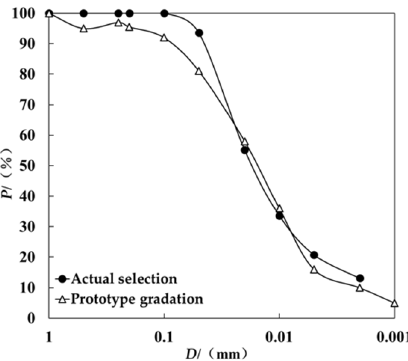
Figure 3. The sediment-particle-grading curves of the model and prototype.